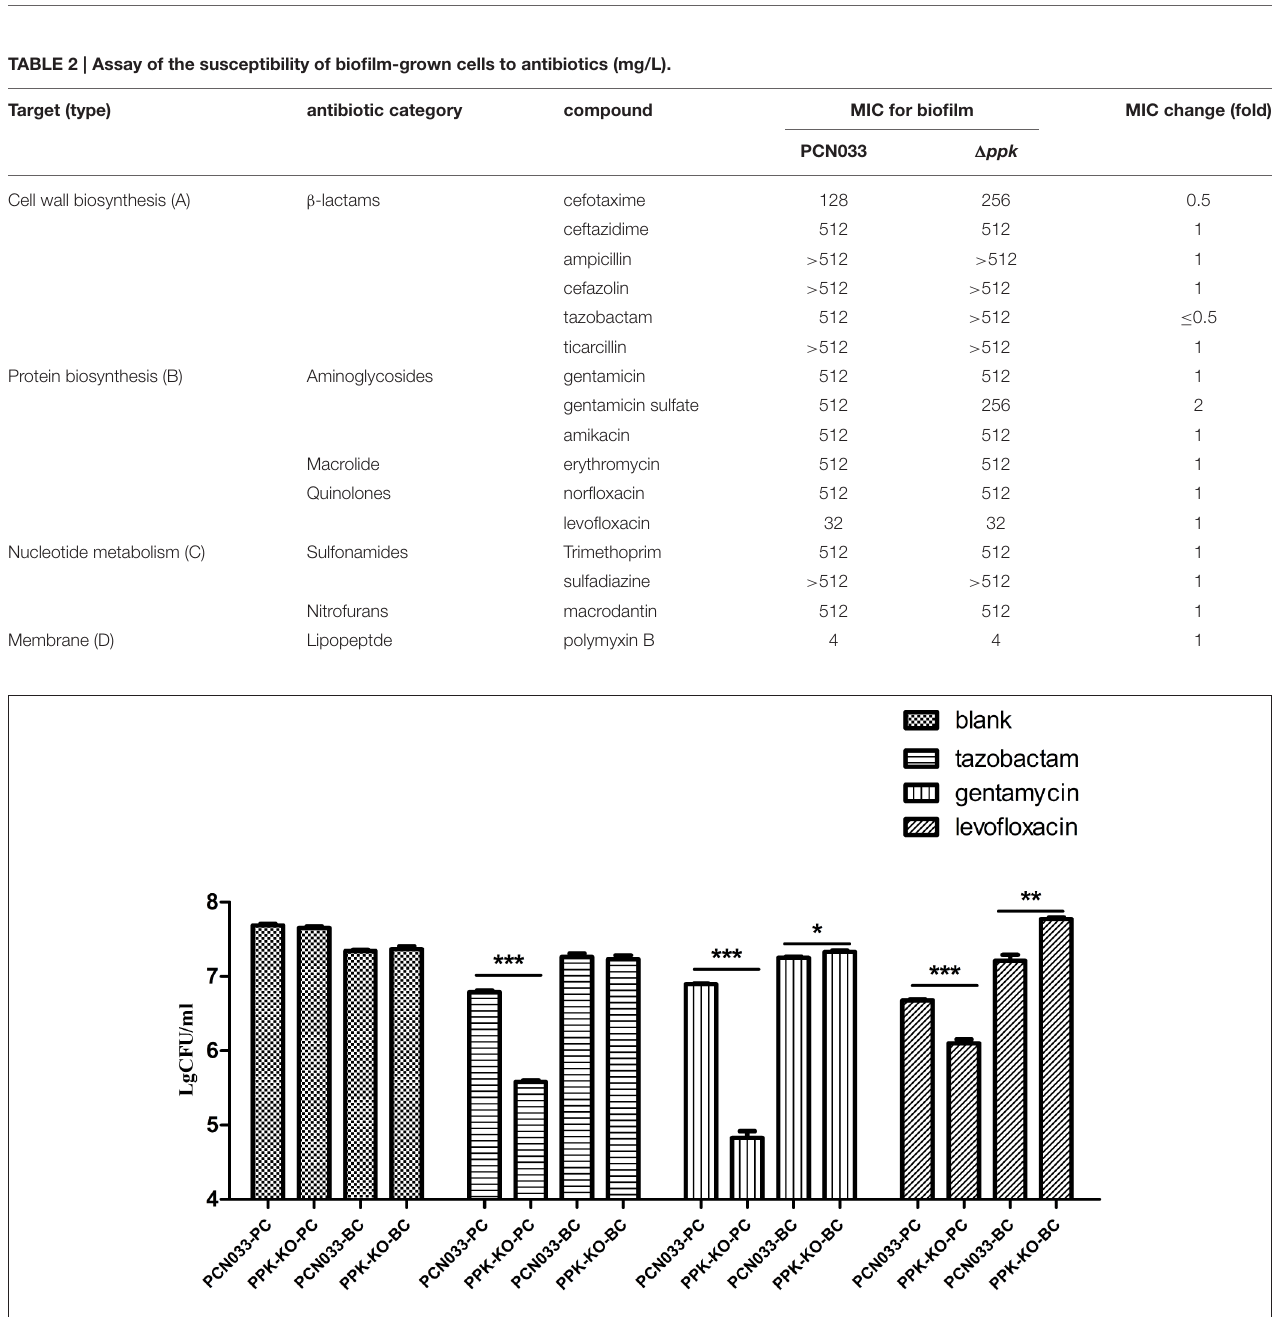
FIGURE 2 | Antibiotic killing assay of planktonic and biofilm-grown cells. PCN033-PC indicates planktonic WT cells; PPK-KO-PC indicates planktonic cells of the 1 ppk mutant; PCN033-BC indicates biofilm-grown WT cells; PPK-KO-BC indicates biofilm-grown cells of the 1 ppk mutant; blank indicates no